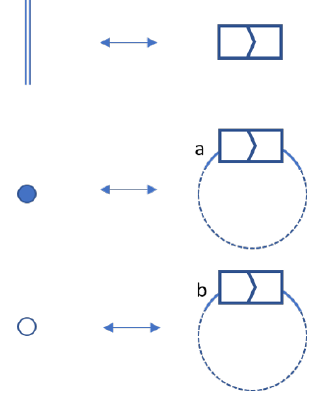
Figure 3 . All the n = 3 graphs at leading order in large- d and one sub-leading non-planer graph. as